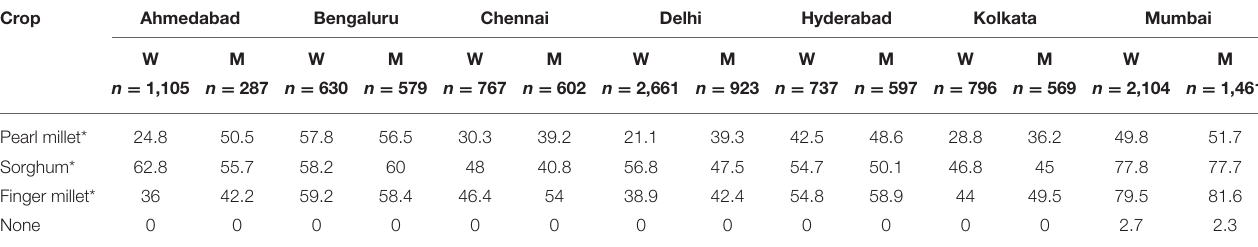
TABLE 2 | Recognition of millets and sorghum in each city (% of respondents). Crop Ahmedabad